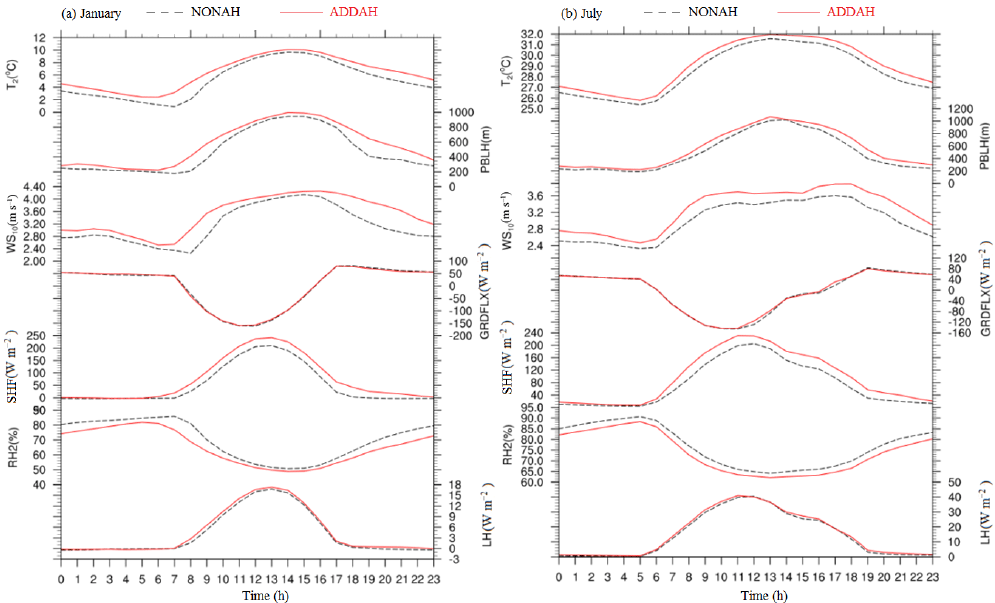
Figure 7. The monthly averaged diurnal variations of modeled meteorological factors in January (a) and July (b) over the urban area of Shanghai. NONAH and ADDAH represent the simulation cases with and without AH fluxes, respectively. LH means latent heat. SHF indicates sensible heat flux. GRDFLX represents heat flux from ground level. T 2 , RH 2 , WS 10 , and PBLH indicate 2m air temperature ( ◦ C), 2m relative humidity (%), 10m wind speed (ms − 1 ) and the height of the planetary boundary layer (m),